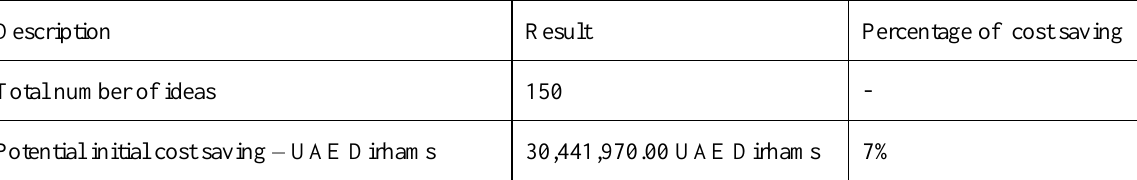
Table 3. Summary of the outcome of VE on example (A). Source: Jayakumar,